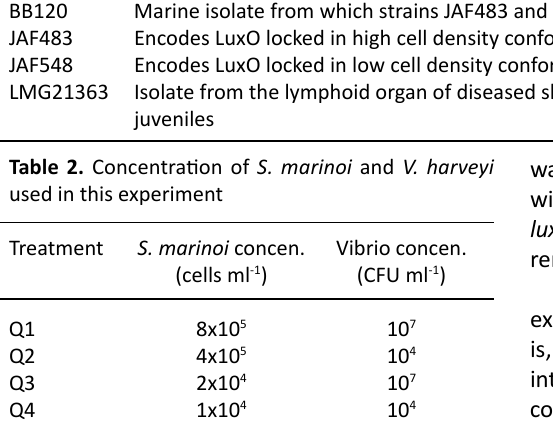
table 1. Wild type and quorum sensing mutants of V. harveyi used in this study Strain Genotype